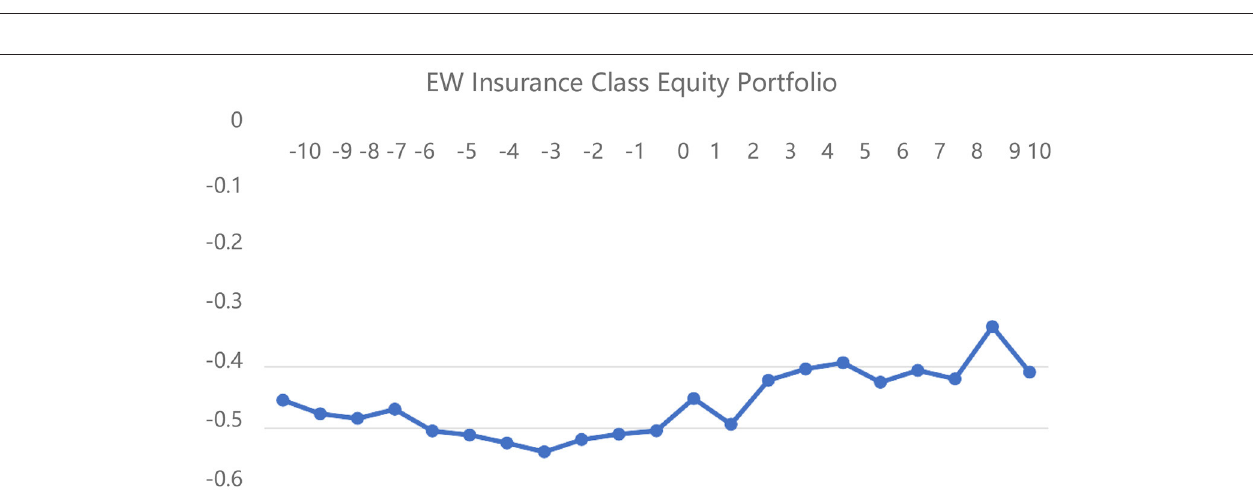
FIGURE 1 | DRNs event selection criteria—“first event” approach.